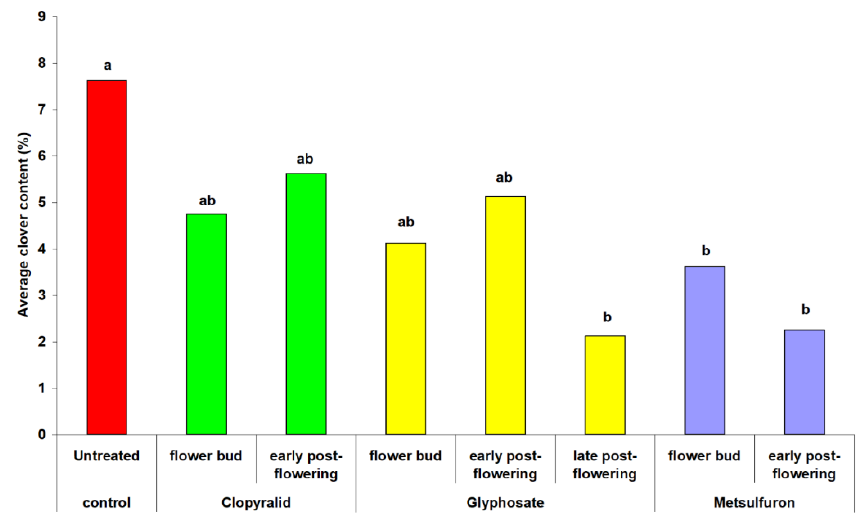
Figure 5. Average clover content of plots at 6 weeks after wiper application of herbicides. Bars with the same letter are not significantly different ( p < 0.05).